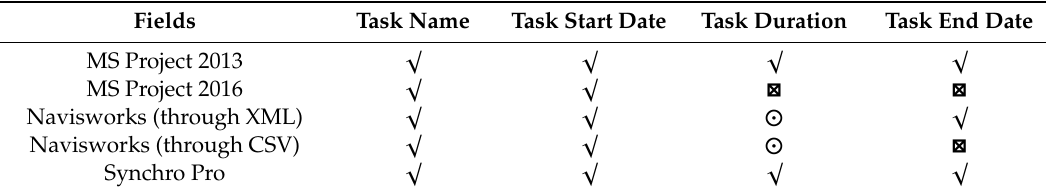
Table 6. Results of tests of BIM interoperability through Gantt charts—Design2Management, obtained by importing the sample Gantt chart into the CPM software packages ( (cid:2) : medium interoperability; (cid:12) : no data